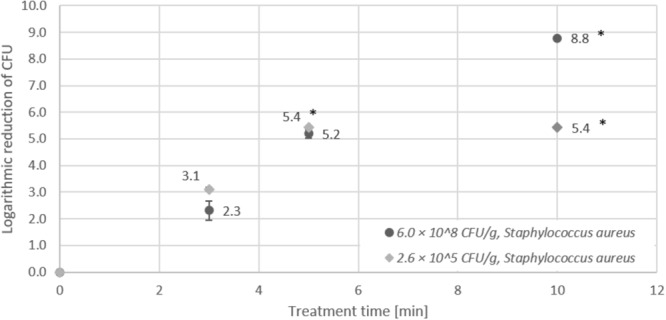
Effect of CAPP treatment of Staphylococcus aureus on lentil seeds. Inoculation was performed either as high initial inoculation (6.0 × 108 CFU/g) or low initial inoculation (2.6 × 105 CFU/g) prior to treatment of seeds for 3, 5, or 10 min in the DCSBD. Logarithmic reductions were represented as log10 CFU/g ± standard deviation. The limit of detection was 10 CFU/g for low initial inoculation and 100 CFU/g for high initial inoculation. Logarithmic reduction below the limit of detection is indicated by an asterisk.